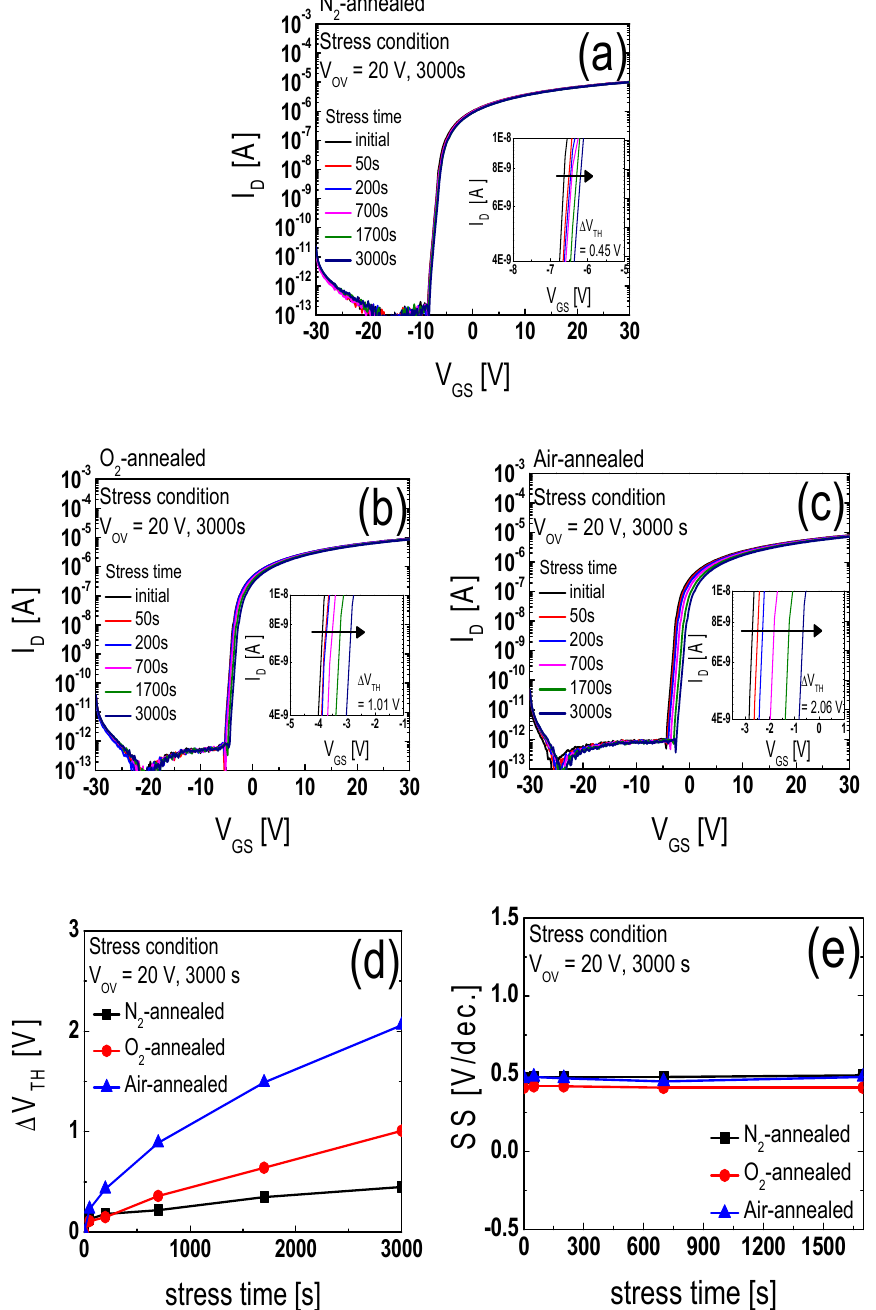
Figure 3. Time-dependence of transfer characteristics of ( a ) N 2 -, ( b ) O 2 -, and ( c ) air-annealed IGTO TFTs, determined under a constant overdrive voltage stress of V OV = 20 V. The insets in ( a – c ) show the shift of transfer characteristics on a magnified scale. ( d ) ∆ V TH values obtained for the N 2 -, O 2 -, and air-annealed IGTO TFTs after subjection to PBS various times. ( e ) Subthreshold swing ( SS ) values obtained for the N 2 -, O 2 -, and air-annealed IGTO TFTs at every PBS